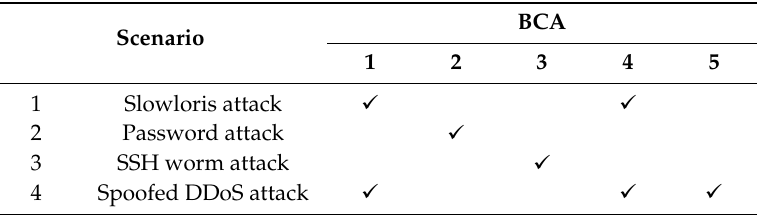
Table 4. Scenarios of known attacks.